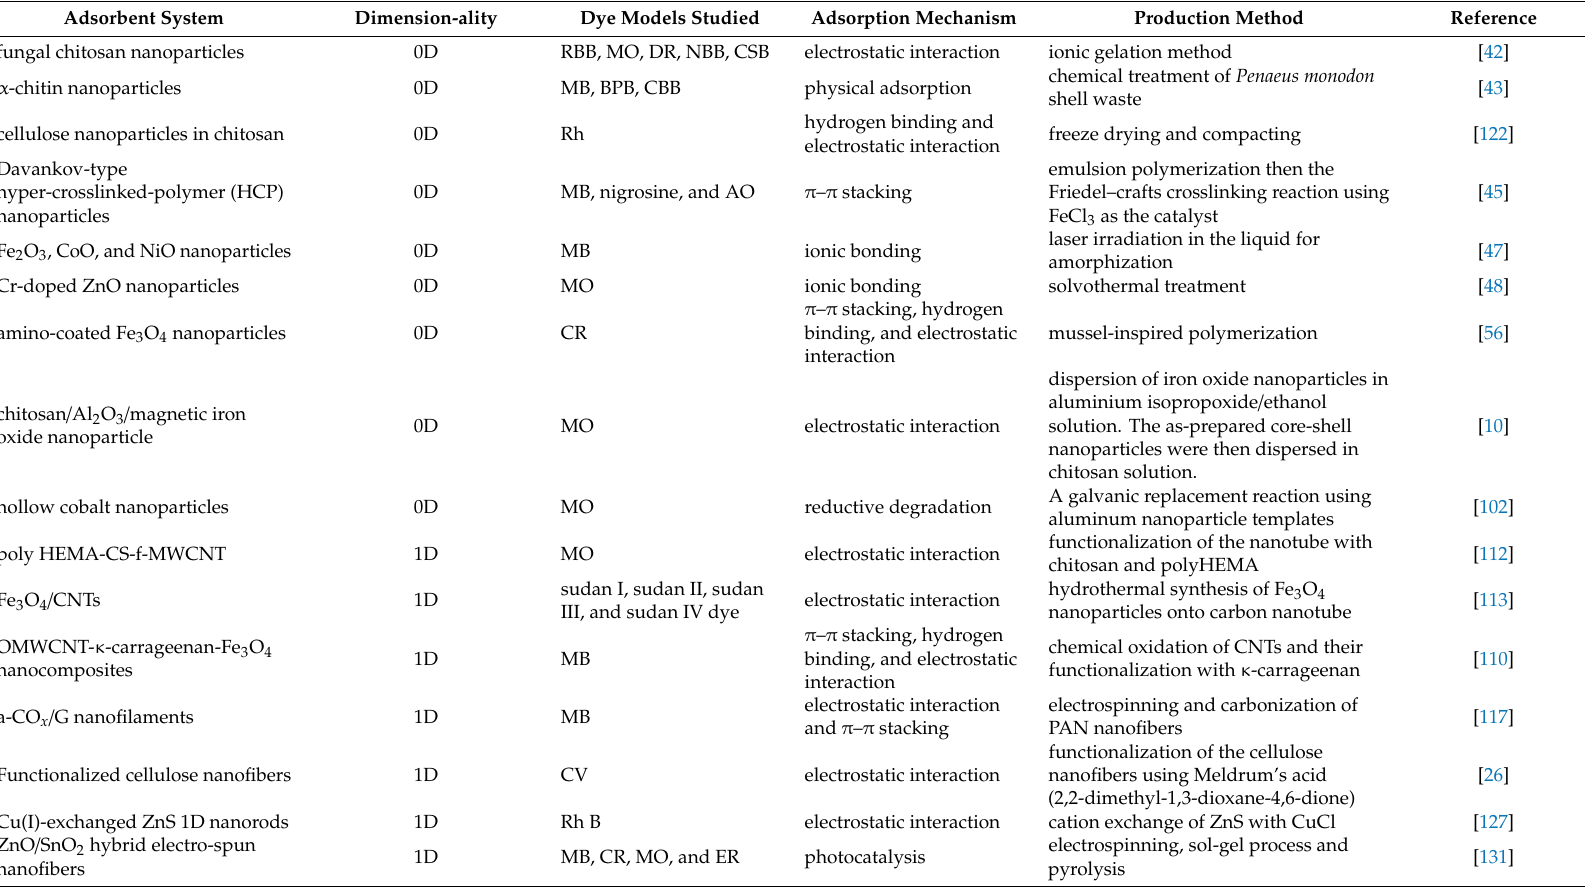
Table 2. A summary of the diverse nanosized adsorbents introduced in this